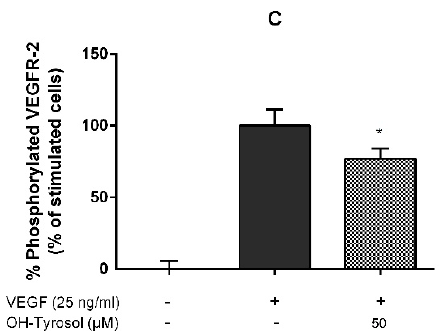
Figure 1. Hydroxytyrosol inhibits vascular endothelial growth factor (VEGF)-induced VEGFR-2 phosphorylation by interacting with cell membrane components. Human umbilical vein endothelial cells (HUVECs) were incubated with 50 µM or 1 µM hydroxytyrosol and VEGF (25 ng/mL). ( A ) Hydroxytyrosol and VEGF were mixed 5 min prior to cells treatment for another 5 min; ( B ) hydroxytyrosol was pre-incubated for 4 h with HUVECs and subsequently incubated with VEGF for 5 min; ( C ) hydroxytyrosol was pre-incubated for 4 h with HUVECs and, after removal of the